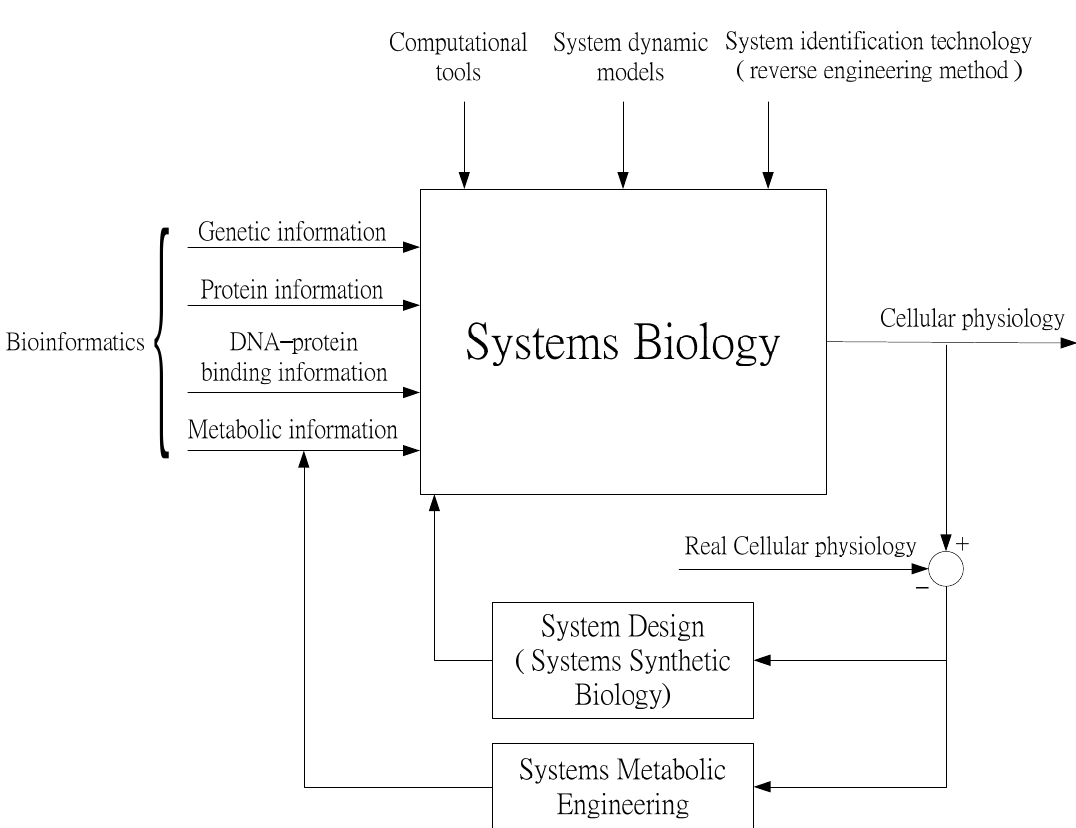
Figure 1. The role of systems biology as an integrated platform in modern biological research Systems biology integrates information on genetics, proteins, DNA-protein binding, and metabolism with system dynamics modeling and system identification technology to develop models and mechanisms for the interpretation of phenotypes or behaviors of cellular physiology. Since large-scale data sets need to be mined, powerful computational tools are necessary. Based on system models and mechanisms in systems biology, synthetic genetic circuits are designed to investigate specific desired cellular behaviors of cellular physiology. Discrepancies between real and desired cellular behaviors are used as feedback to adjust system models and mechanisms. Systems biology is thus positioned to play the role of integrated platform for bioinformatics, systems synthetic biology, and systems metabolic